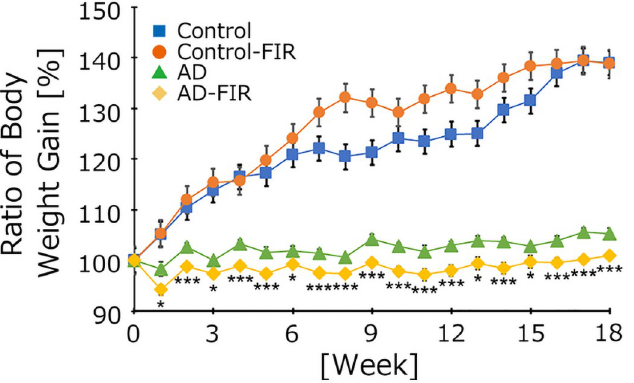
Fig 2. Relative body weights in treatment groups. Body weight was measured once per week for 5 consecutive months. Values were normalized to baseline (defined as 100%). Data are expressed as means ± SE (Control, n =